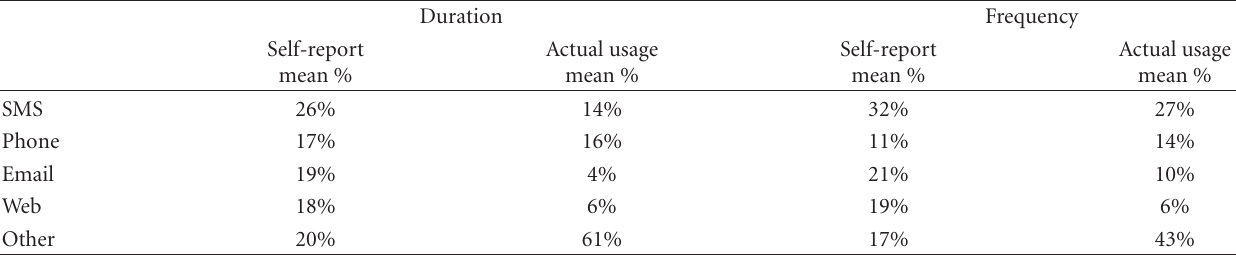
Table 3: Percentages of time spent on iPhone applications from both self-reports and actual